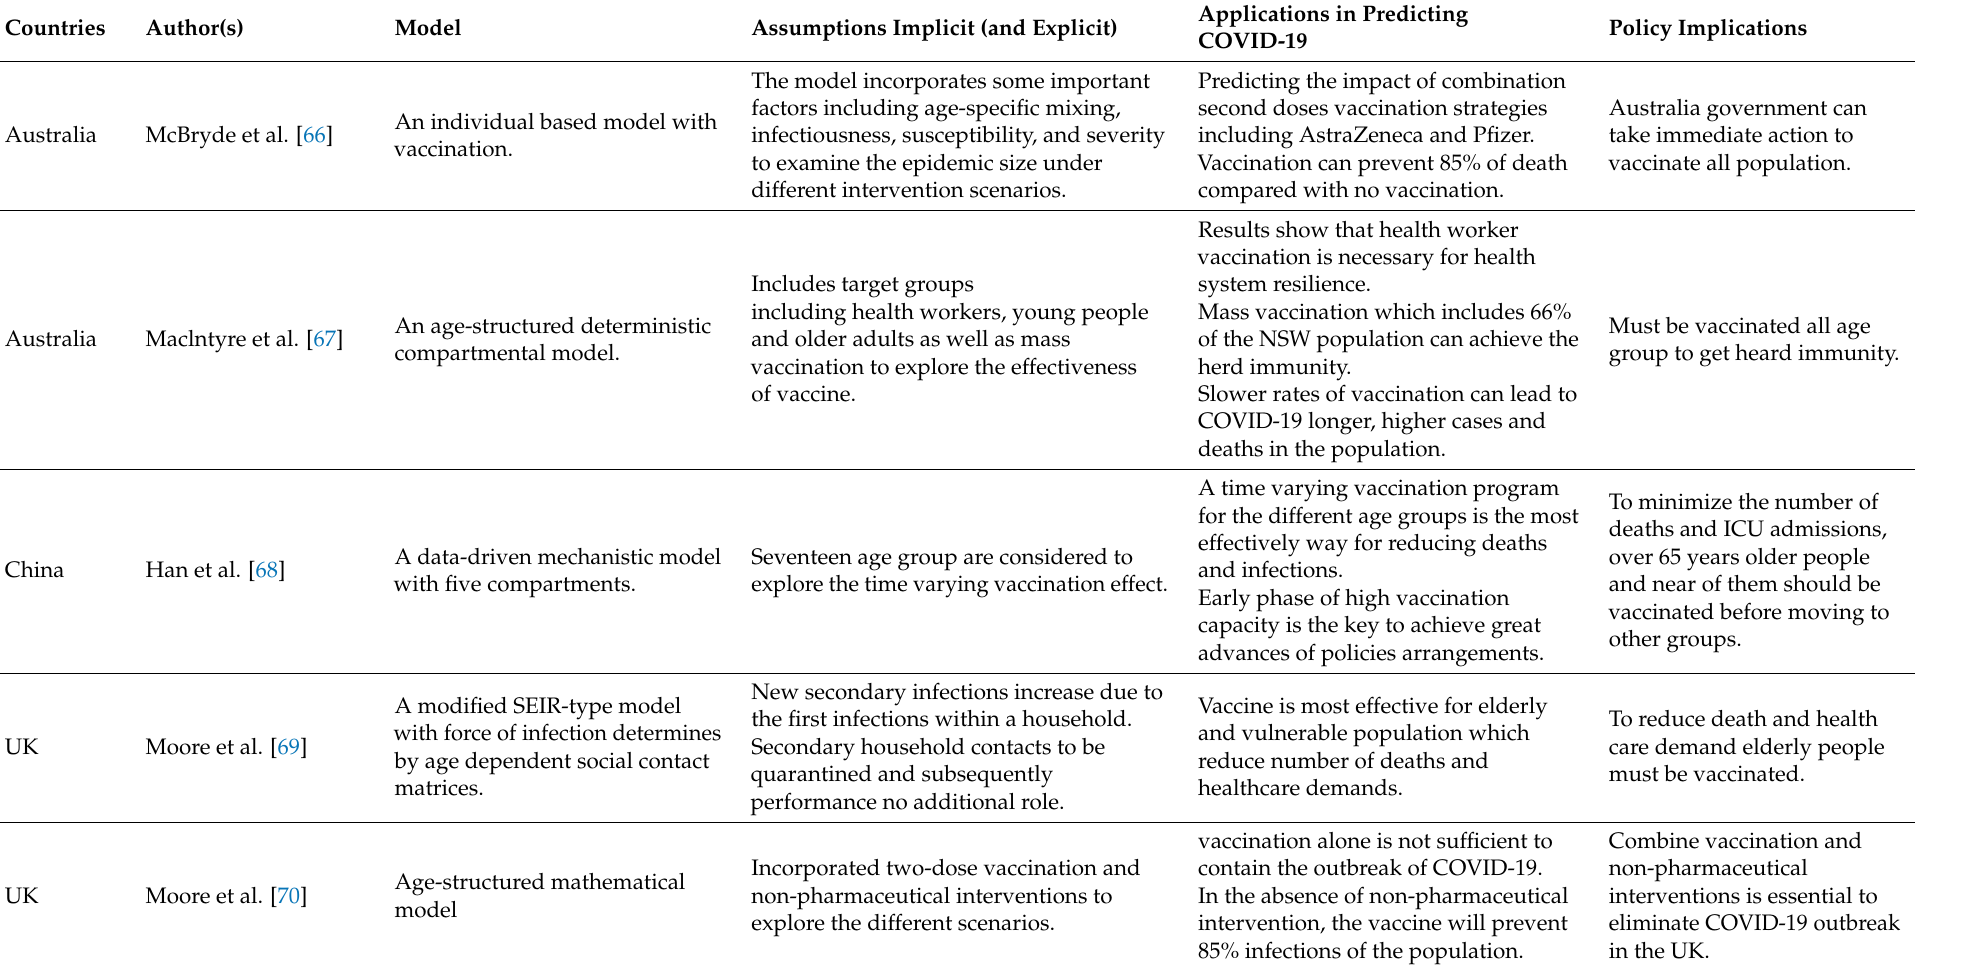
Table 2. Some current models that include vaccination strategies in China, the UK, and